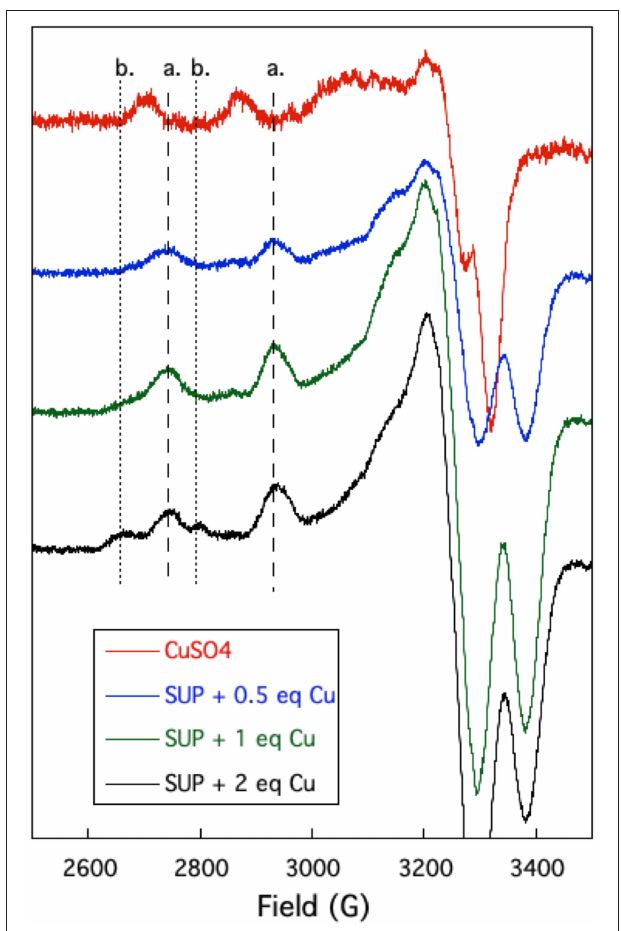
FIGURE 5 | Changes in the EPR spectrum of Cu 2 + in the presence of SUP. The spectra indicate the presence of two distinct Cu 2 + binding sites.